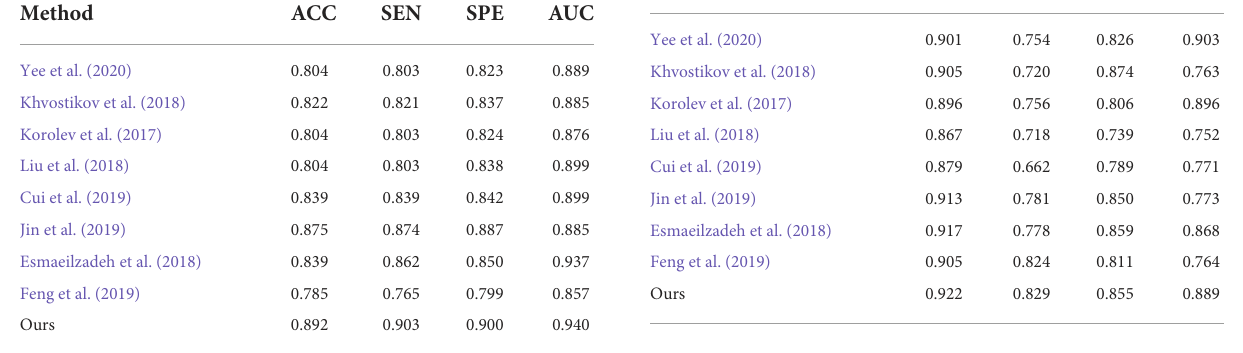
TABLE 4 Comparison of our method with previous deep-learning studies (AD progression detection based on the ADNI dataset). Method